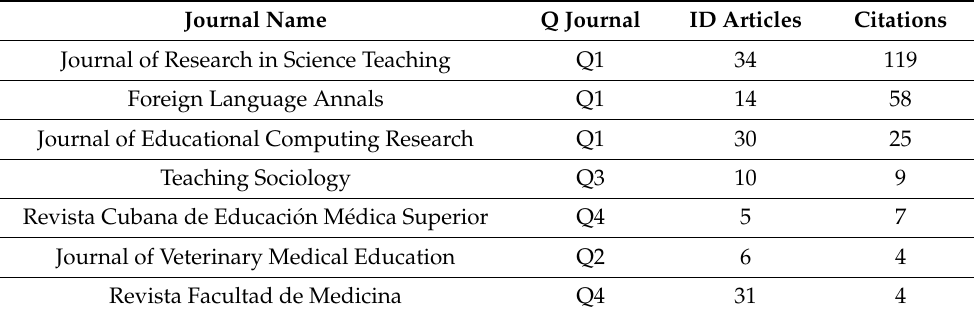
Table 3. Journals and citations of the analyzed